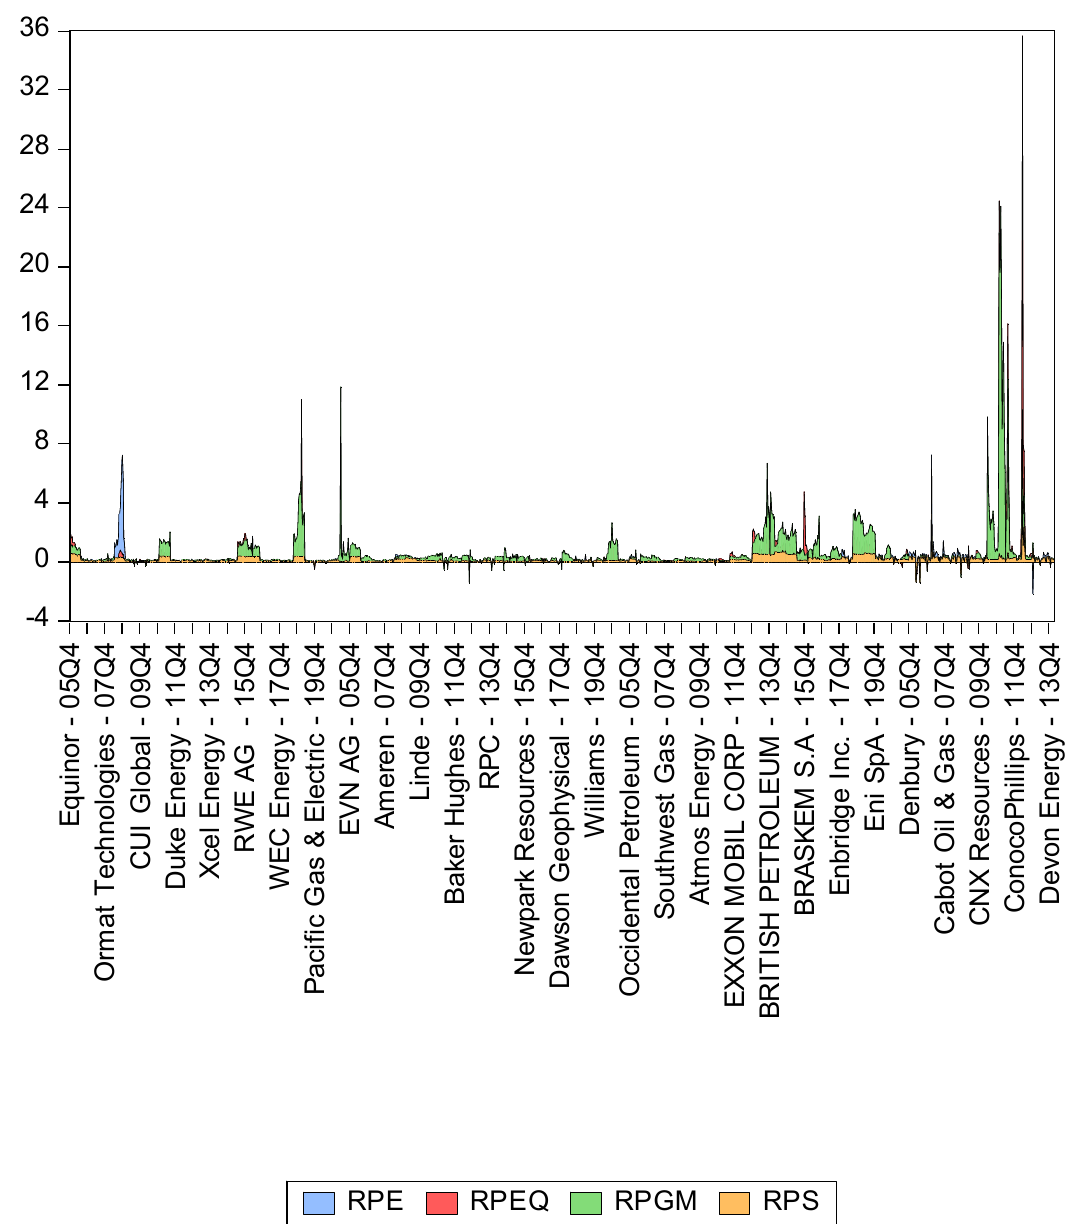
Figure 8. Evolution of fiscal pressure indicators for all energy companies in the sample.